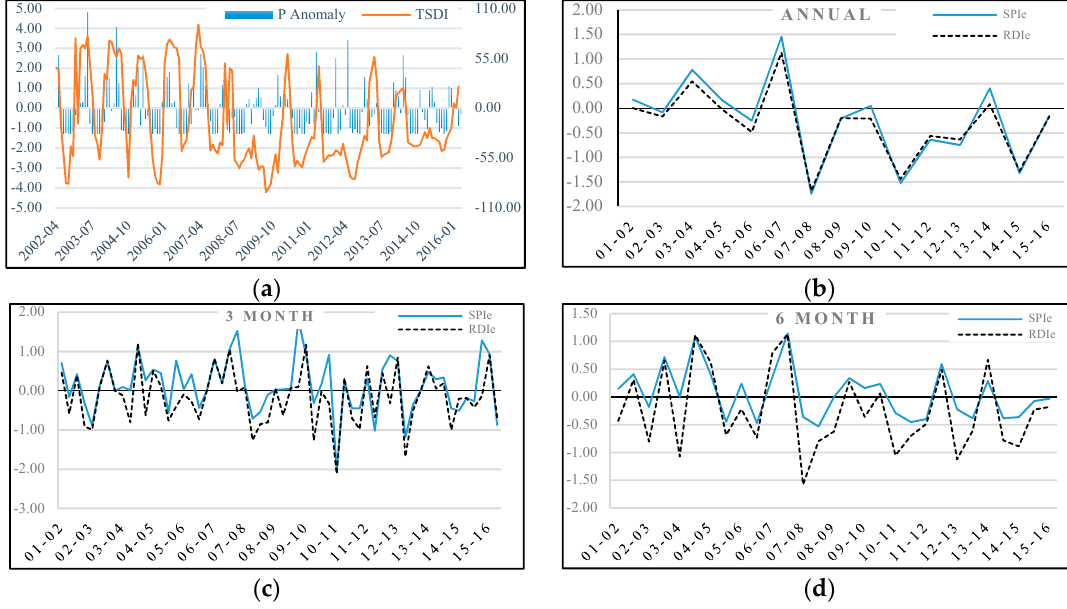
Figure 9. Drought detection and monitoring in the semi-arid zone of the studied area by ( a ) TSDI; ( b ) Annual SPI and RDIe; ( c ) SPI-3 and RDIe-3; ( d ) SPI-6 and RDIe-6.